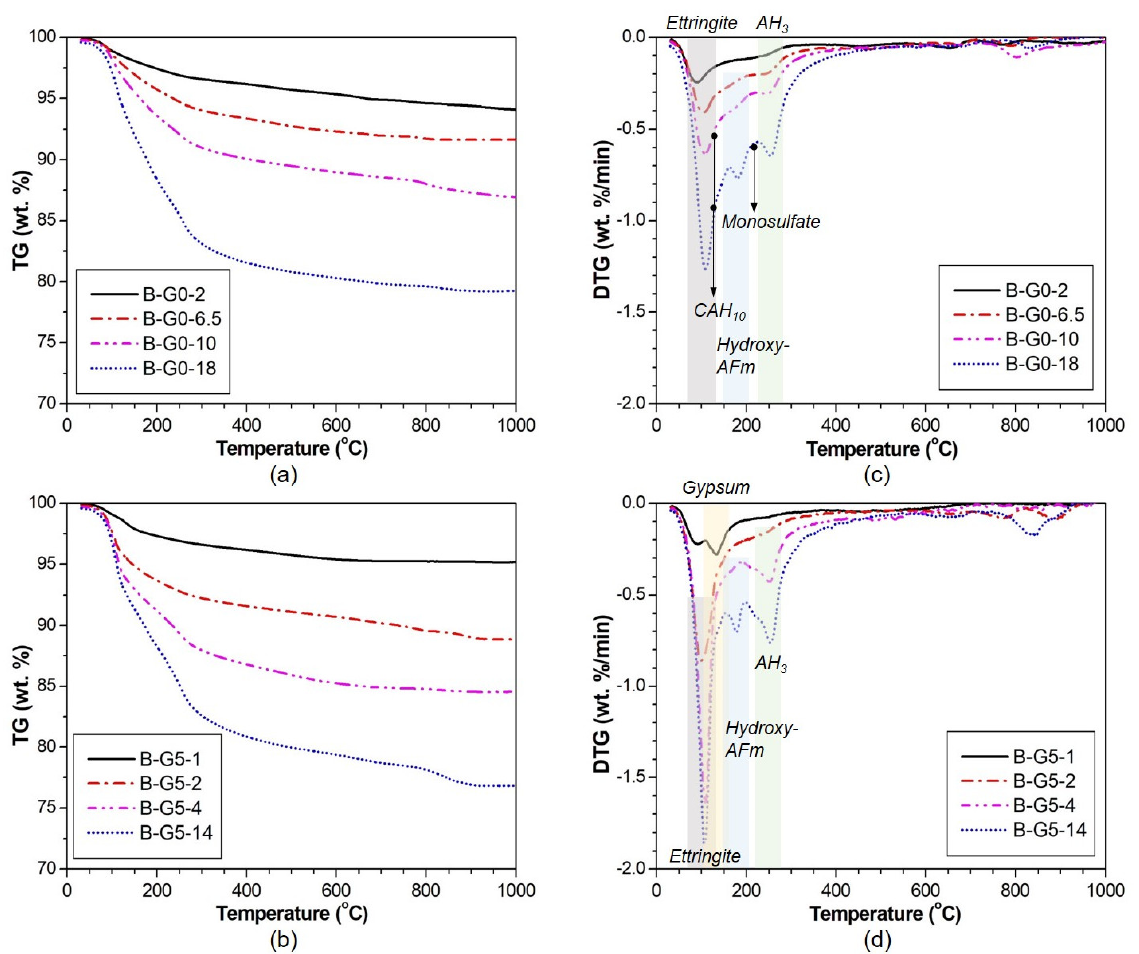
Figure 9. TG and DTG curves for B-G0 and B-G5 at each curing time. ( a ) TG curve of B-G0; ( b ) TG curve of B-G5; ( c ) DTG curve of B-G0; ( d ) DTG curve of B-G5.